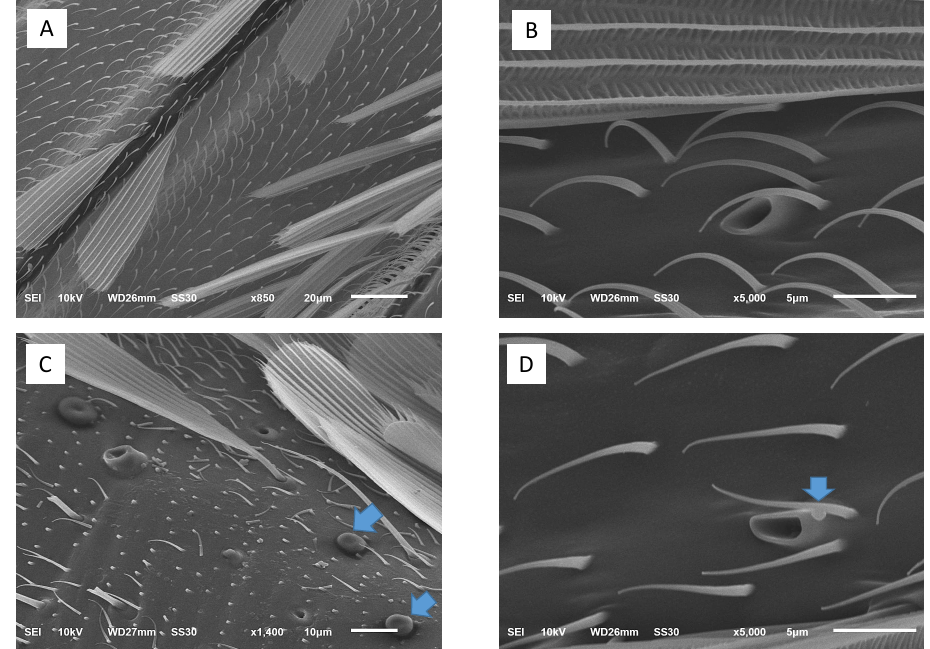
Figure 4. Ultrastructures of the mosquitoes with and without PM 2.5 exposure: ( A , B ) a negative control mosquito showing no particles on the mosquito’s body and no obstruction around the spiracles; ( C , D ) a PM 2.5 -exposed mosquito showing particles on the body and no obstruction around the